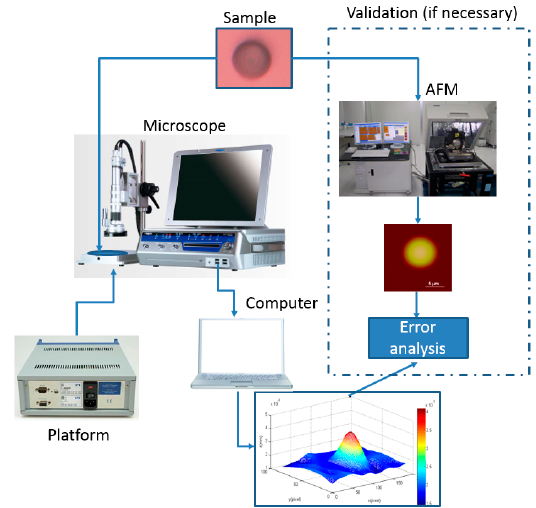
Figure 7. The connection of our experiment.